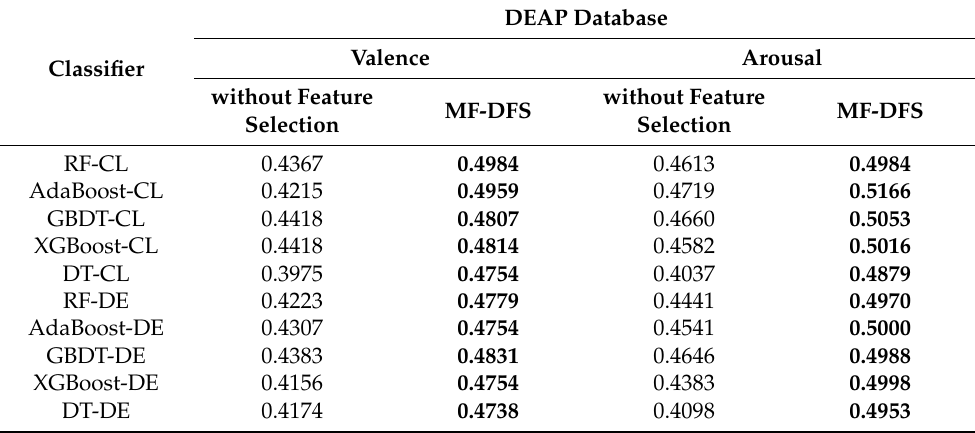
Table 7. Classification accuracy comparison across different machine learning methods in two different feature sets on the DEAP database.